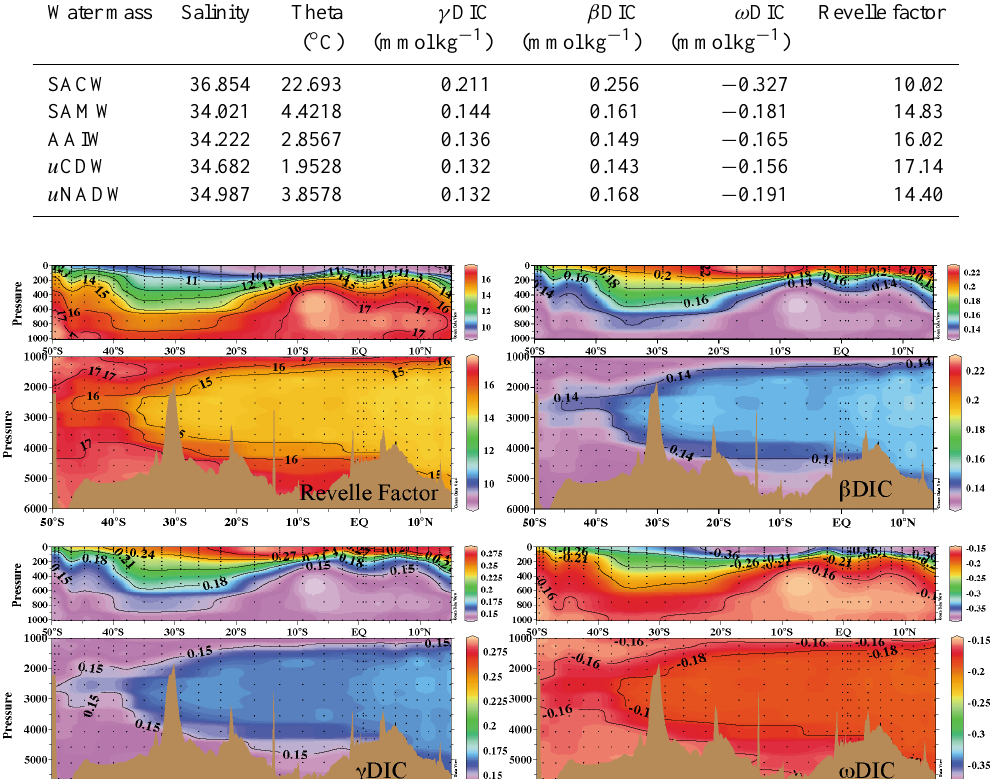
values of 0.148, 0.141 and 0.143 mmol kg − 1 ,